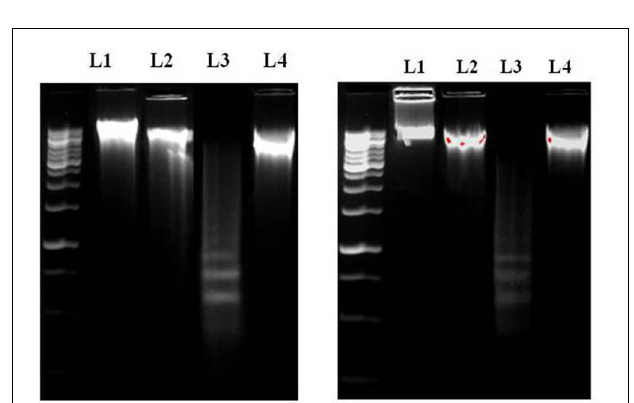
however, did not show any significant change compared to normal ( Figure 5B